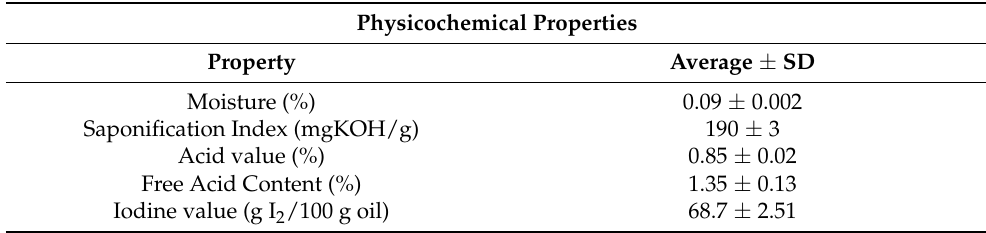
Table 1. Physicochemical characterization of waste cooking oil (WCO). Values are the averages of triplicate determinations ± standard deviation (SD).